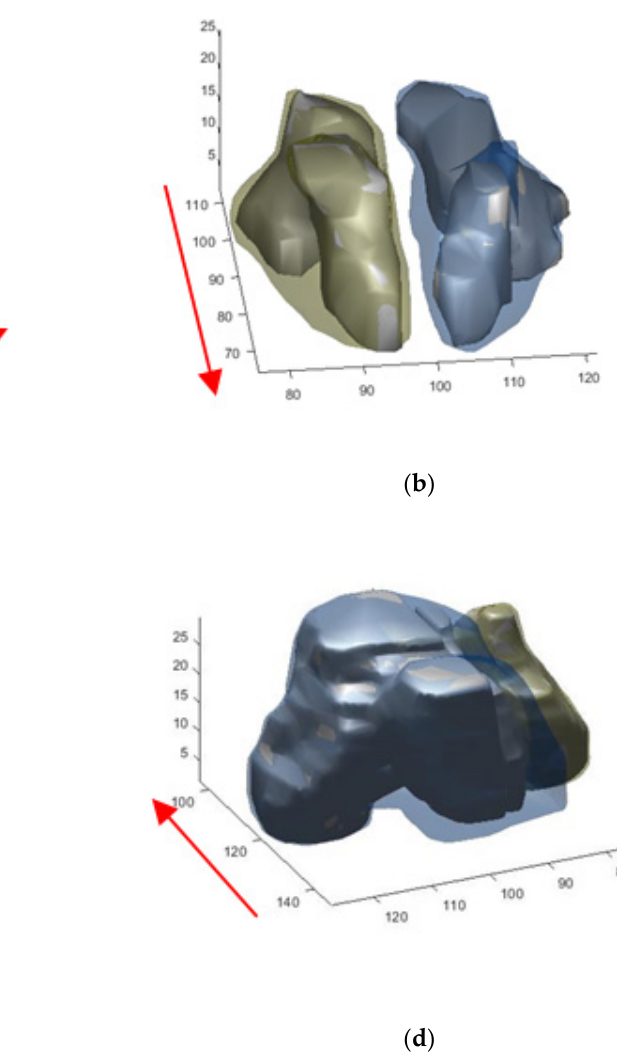
Figure 25. Resulting images of Marching Cube 3D reconstruction of sinus mucosa inflammation.